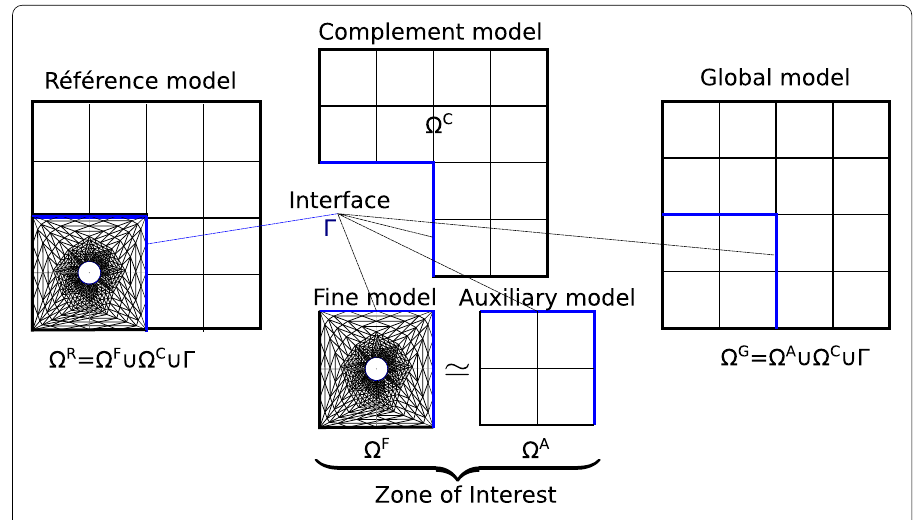
Fig. 1 Illustration of the models (with meshes). In practice the Reference and Complement models are not created. The zone of interest has a Fine and an Auxiliary